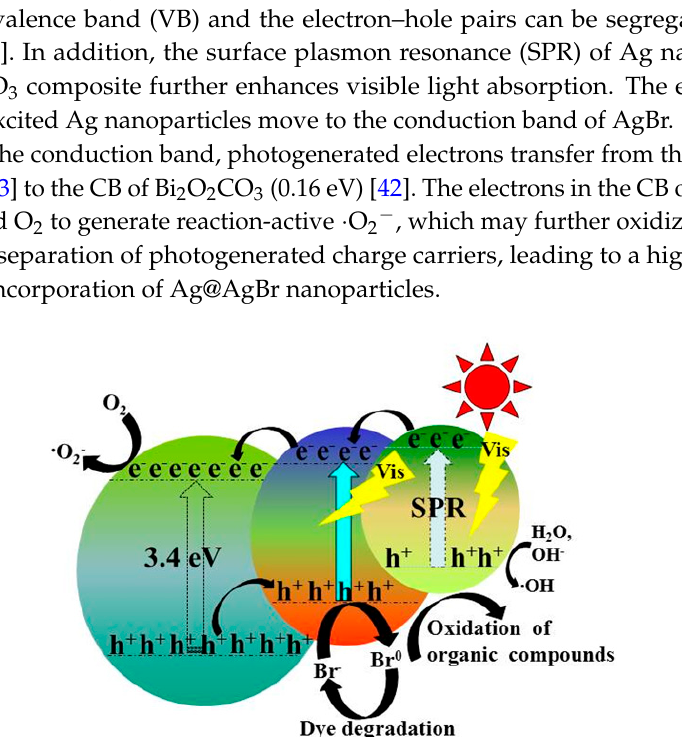
Figure 13. ( a ) The kinetic plots of photocatalytic degradation of BPA under visible light irradiation; ( b ) UV-vis spectra obtained at different reaction times in visible light-induced BPA photocatalytic degradation on Ag@AgBr(7 wt %)/Bi 2 O 2 CO 3 ; ( c ) TOC removal of BPA over various photocatalysts under visible light irradiation